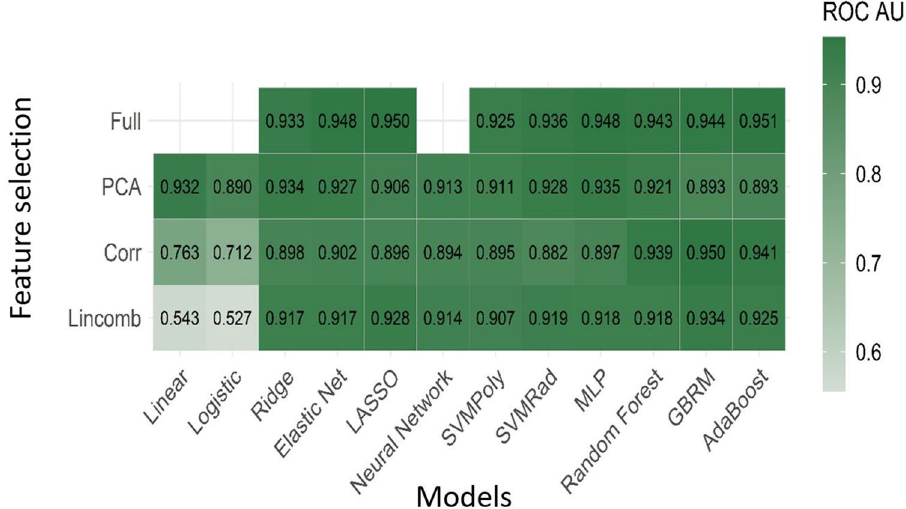
Figure 3. Diagnostic performance using combined T1- contrast enhanced (T1-CE) and FLAIR sequence. Mean AUC for all models fit using the combined T1-CE and FLAIR